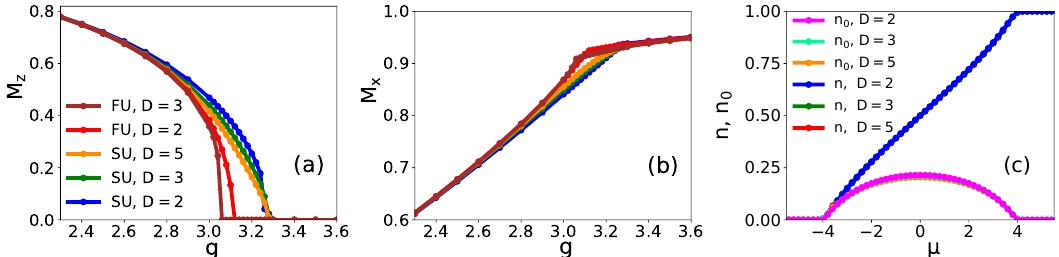
Figure 10: Ground state results benchmarking our iPEPS implementation. Panels (a,b) show (a) the longitudinal magnetization M M as a function of transverse field g (in units of J ) in the vicinity of phase transition x of the transverse field Ising model. These are computed for different iPEPS bond dimensions D using both SU and FU as indicated. Panel (c) shows number density of bosons n per lattice site and the condensate fraction n Hubbard model as a function of chemical potential µ (in units of J ), computed for different iPEPS bond dimensions D using